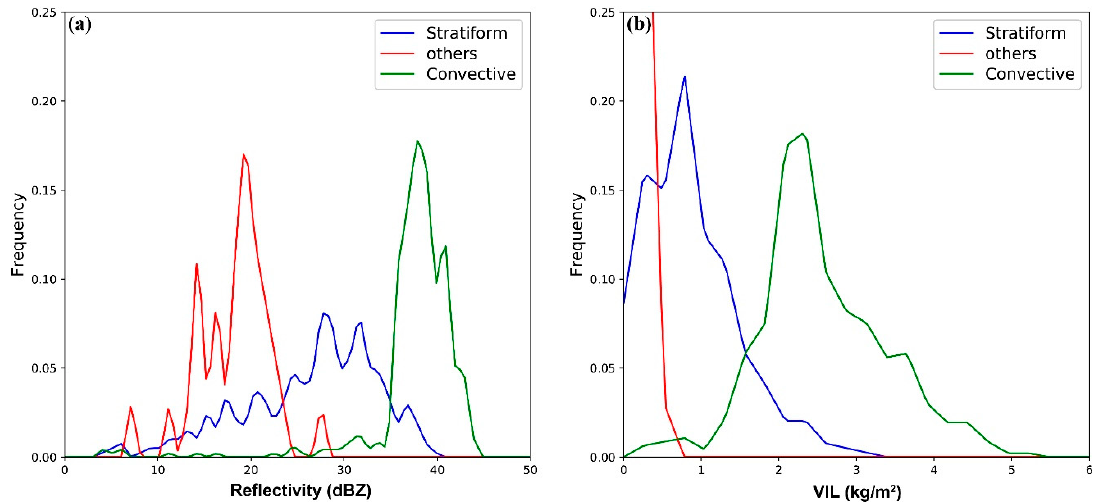
Figure 1. The variations in different types of precipitation frequency as a function of ( a ) Horizontal distribution characteristics of radar reflectivity at a height of 2 km (ref2km) and ( b ) Vertically integrated liquid water content (VIL).